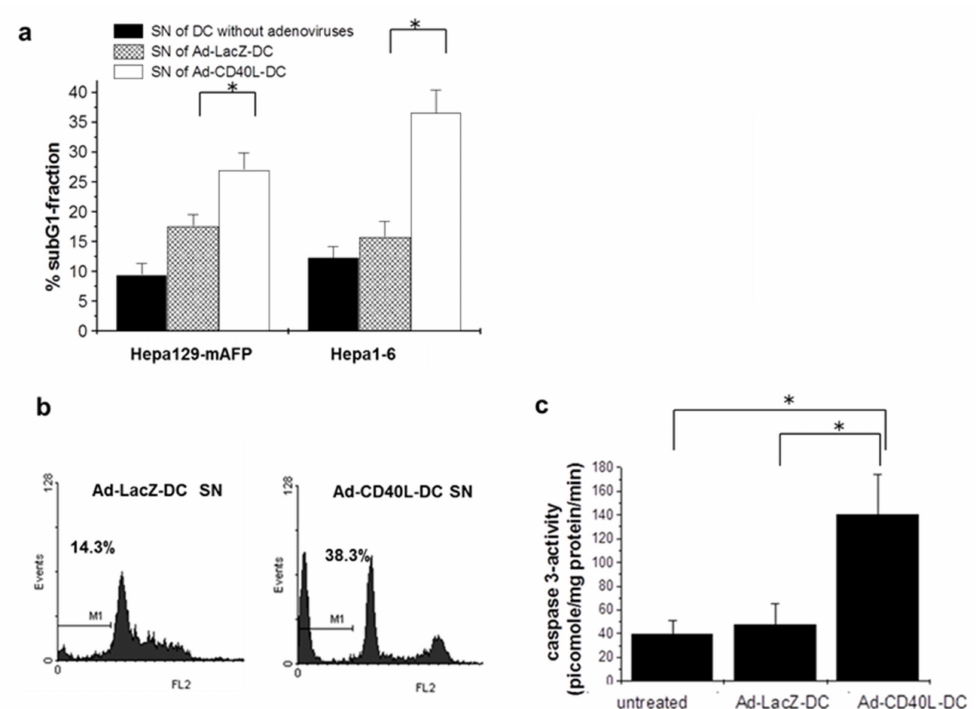
Figure 7. Analysis of tumor cell apoptosis. ( a ) Apoptosis assessment by detection of the sub-G1-fraction in tumor cells 72 h after culturing with the supernatant (SN) from Ad-CD40L-DC. Data are shown as mean ± SD from one representative experiment of four independent experiments. (* p < 0.05). ( b ) Flow cytometry of two representative samples of Hepa1–6 cells subG1-fraction after culturing with the SN of Ad-CD40L-DC or Ad-LacZ-DC. ( c ) Caspase-3 activity in protein lysates from explanted tumors after i.t.-injection with Ad-CD40L-DC. Mean ± SD of activity (AFC= turnover in pmol/mg protein/min) is shown ( n = 4 each group). (* p < 0.05). Significance was determined using Mann-Whitney-test ( a,b ) or the paired t -test ( c ). Con A: Concavalin